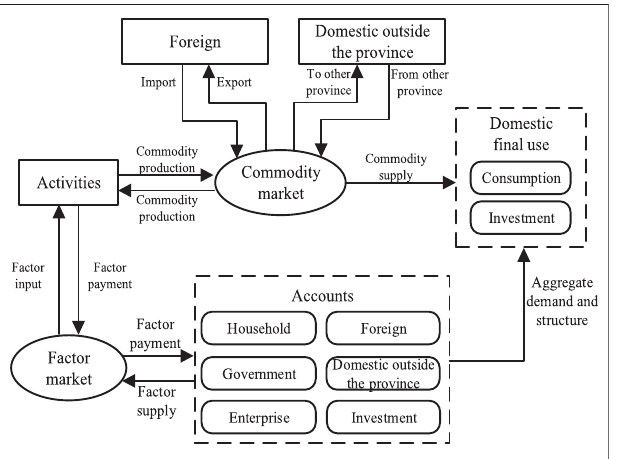
FIGURE 1 | Model structure of CGE.